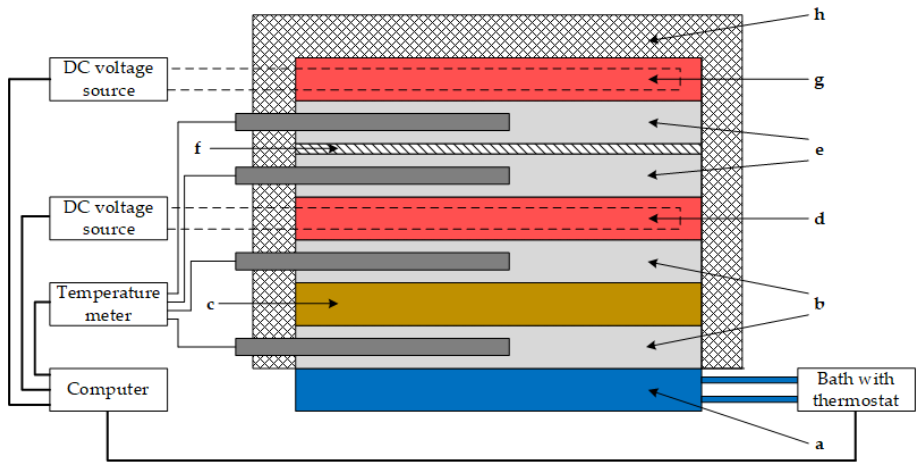
Figure 1. System for measuring the thermal conductivity coefficient λ of solid materials; a —cooler,